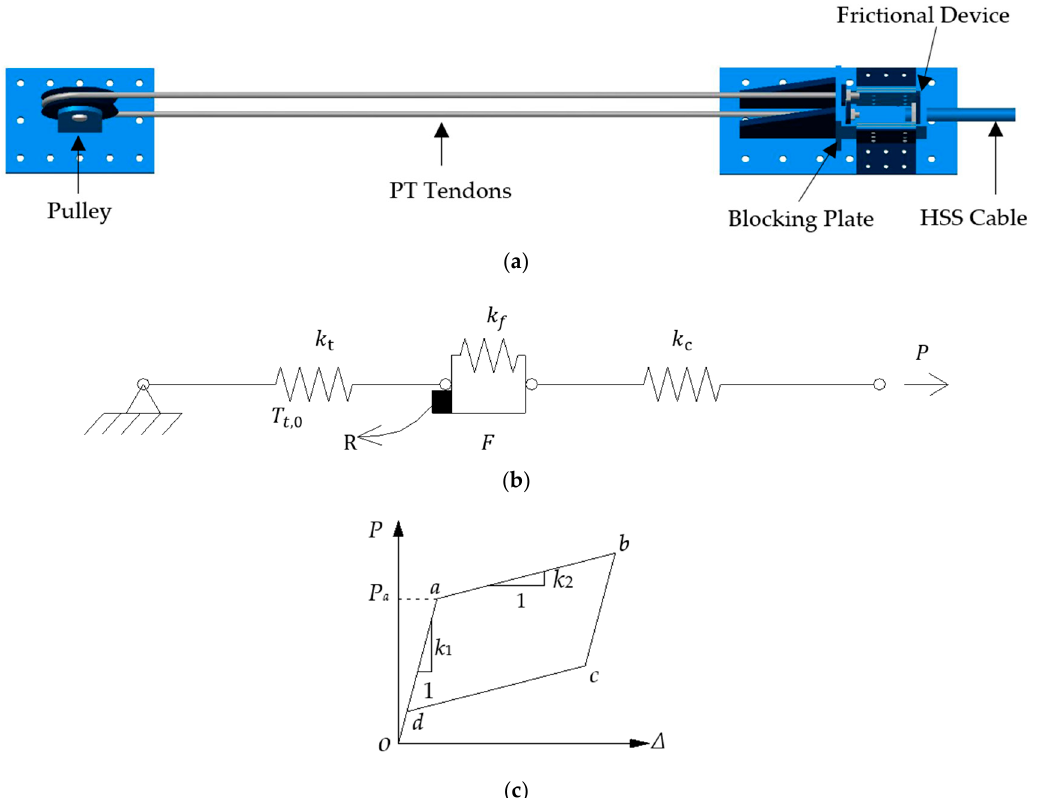
Figure 1. Self-centering tension-only brace (SC-TOB) system: ( a ) schematic; ( b ) analytical model; and ( c ) hysteretic behavior [27,28].